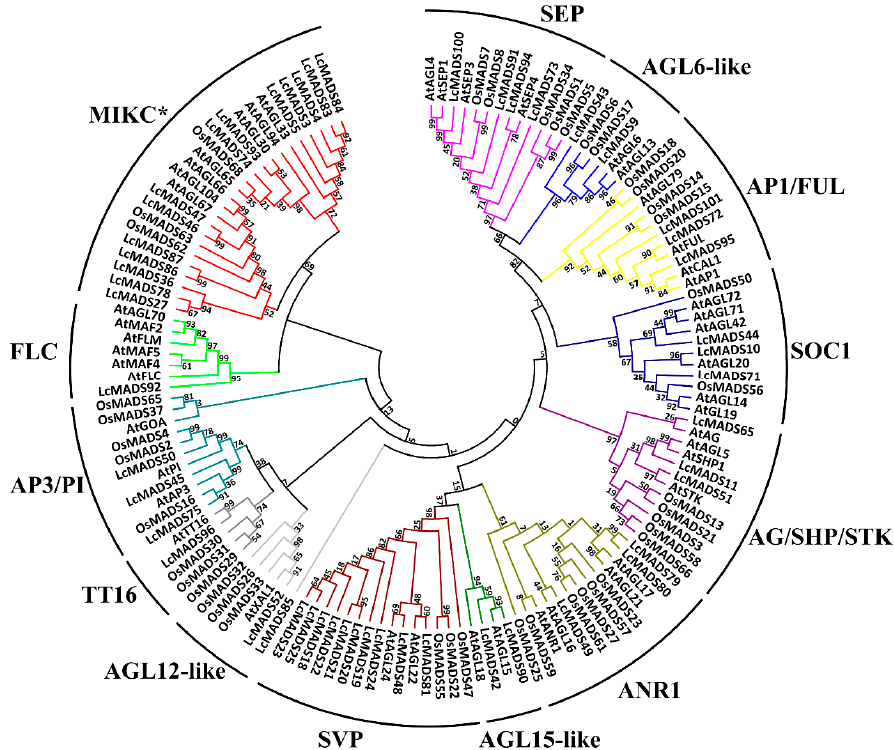
Figure 3. Phylogenetic relationship analysis of type I (top) and type II (bottom) MADS-box transcription factors in litchi, Arabidopsis , and rice, based on construction of a maximum likelihood tree. Type I members were grouped into 3 subfamilies, while type II members were grouped into 13 subfamilies as indicated by different branch colors. Abbreviations: ANR1: ANTHOCYANIDIN REDUCTASE 1; FUL: FRUITFULL; TT16: TRANSPARENT TESTA 16.